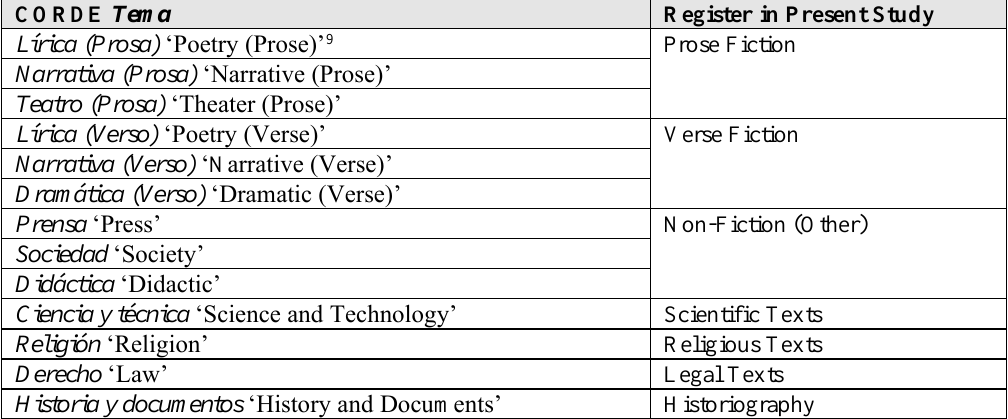
Table 2. Classification of registers